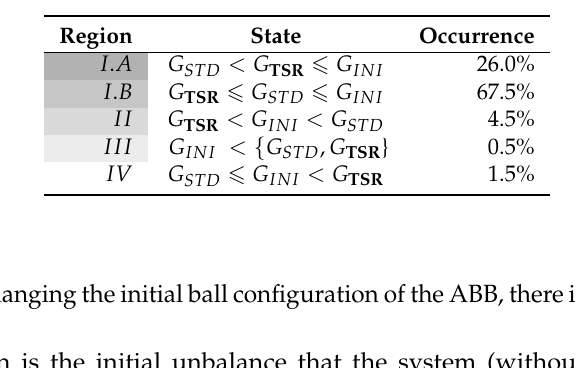
Table 2. Occurrence of each balancing outcome